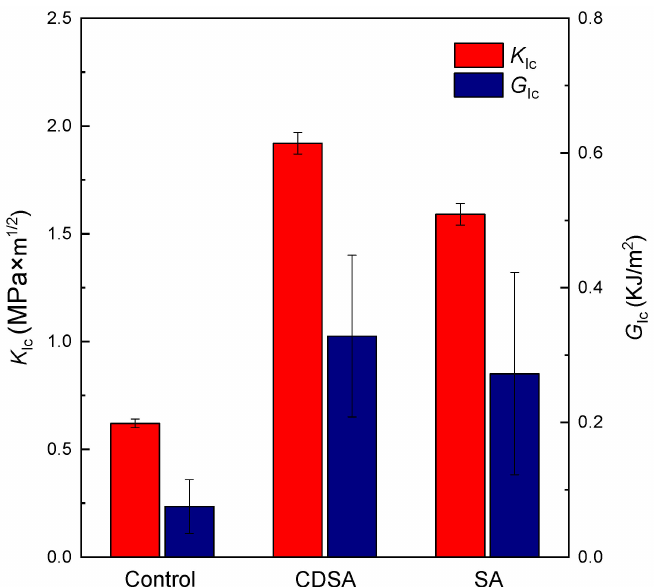
Figure 11. K IC values and G IC values of the control and nanostructured thermosets containing 10 wt% of PCL- b -PE- b -PCL via CDSA or